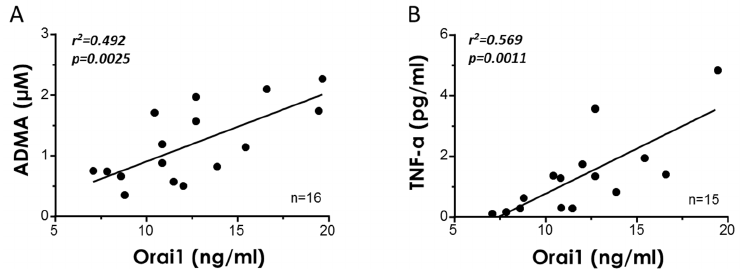
Figure 5. Plasma Orai1 concentrations are associated with biomarkers of endothelial dysfunction and inflammation. Simple regression analysis for plasma concentrations of Orai1 with respect to the plasmatic levels of asymmetric dimethyl arginine (ADMA) ( A ) and tumor necrosis factor- α (TNF- α ); ( B ) determined in the samples from the same subjects. Coefficients of determination (r 2 ) and p values (in bold italic when significant) are indicated for each association. n indicates the number of subjects for determinations.